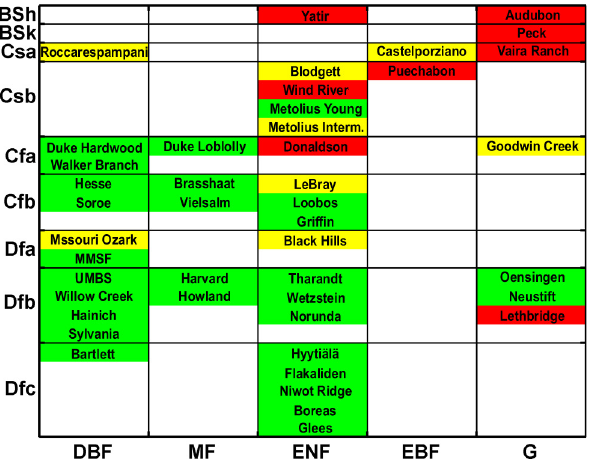
Fig. 3. Study sites in a vegetation-climate matrix; within one class, the sites are ranked according to their mean temperature from top to down. The performance of the Jarvis et al. (2004) model is in- dicated in 3 categories: good (green, r 2 > 0.8), moderate (yellow). bad (red, r 2 < 0.5). Koeppen-Geiger-climate classes: steppe cli- mate (BS), temperate (C), continental (D); summer dry (s), fully humid (f); hot (h), cold in winter (k); hot summer (a) , warm sum- mer (b) , cool summer (c) , cold winter (d) ; vegetation classes: de- ciduous broadleaf forest (DBF), mixed (MF), evergreen needleleaf (ENF), evergreen broadleaf (EBF), grass